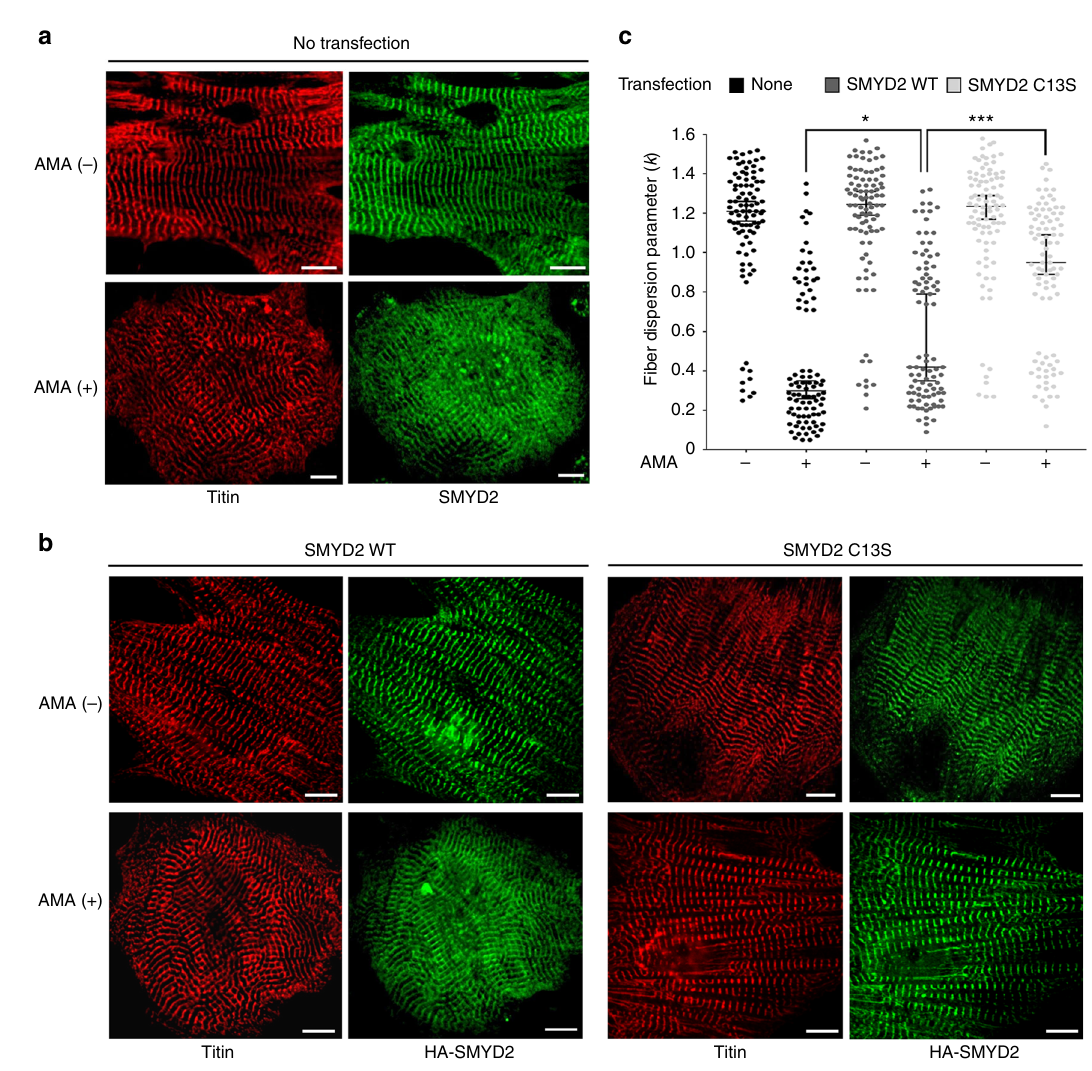
Fig. 4 SMYD2 Cys13 glutathionylation or oxidation reduces myo fi bril integrity. a , b Monitoring the myo fi bril alignment in rat neonatal cardiomyocytes upon incubation of AMA (2 µ g/mL) for 12 h: no expression ( a ) and ectopic expression of SMYD2 WT or C13S ( b ). Immunostainings were done by using antibodies to SMYD2, HA (green), or titin ( α -titin-NT, red). About 30 cells were photographed and examined for myo fi bril alignment or directionality by FiberFit software. 34 Images represent the major myo fi bril structure in individual conditions. Scale bars, 10 µ m. c Analysis of myo fi bril alignment in cardiomyocytes. Individual cell images were analyzed by the FiberFit software to determine the fi ber dispersion parameter ( k ) values that represent the degree of fi ber alignment. High k values represent the aligned networks, whereas low k values represent the disordered networks. The median values with 95% CI are shown, n = 3 independent experiments. Difference is signi fi cant by one-way ANOVA, followed by Tukey ’ s post-hoc test, * p < 0.05, ** p < 0.01, *** p < 0.001, **** p <